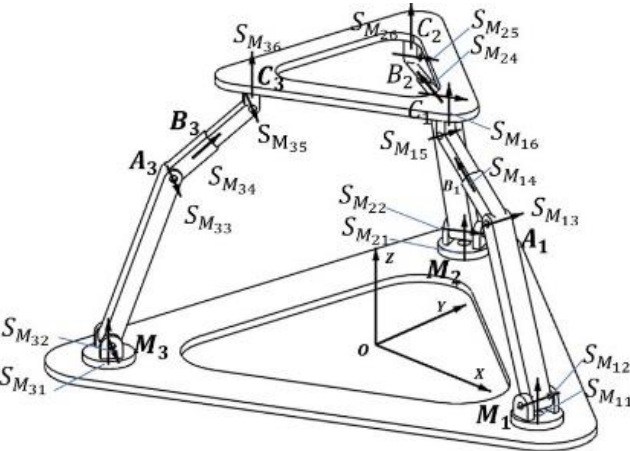
Figure 4. Schematic diagram of the parallel truss mechanism.